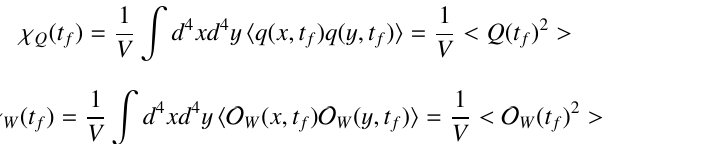
Figure 2. Cross correlation m π = 411 , 701 MeV results respectively. Errors were estimated using an autocorrelation analysis technique described in